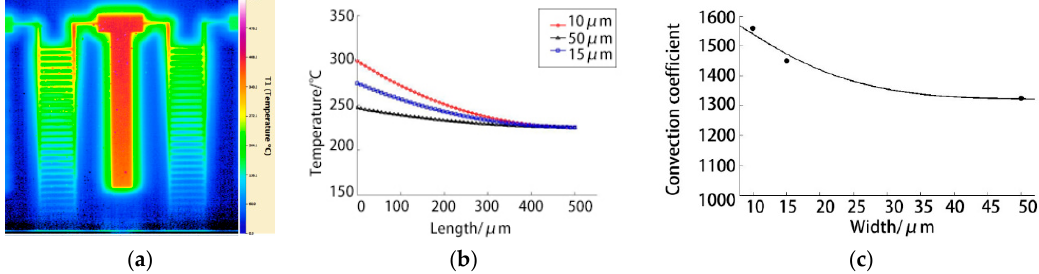
Figure 6. Effect of feature size on the heat transfer parameters: ( a ) Measured temperature field of cantilever beam test specimens with a width of 50 µm; ( b ) fitting results of the heat transfer parameters; ( c ) variation of the heat transfer parameters with characteristic size.